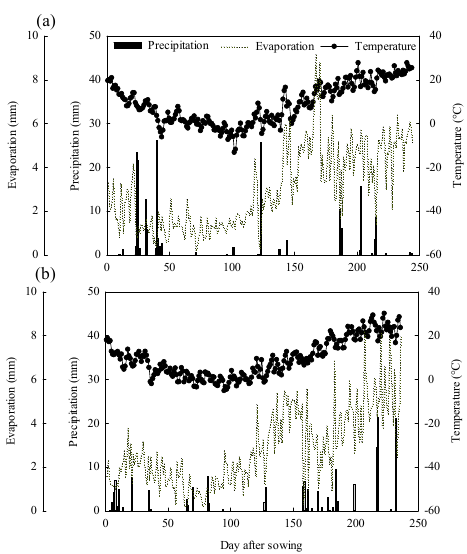
Figure 1. Precipitation and daily mean temperature during the winter wheat growing seasons (October–June) in 2015–2016 ( a ) and 2016–2017 ( b ) in Kenli